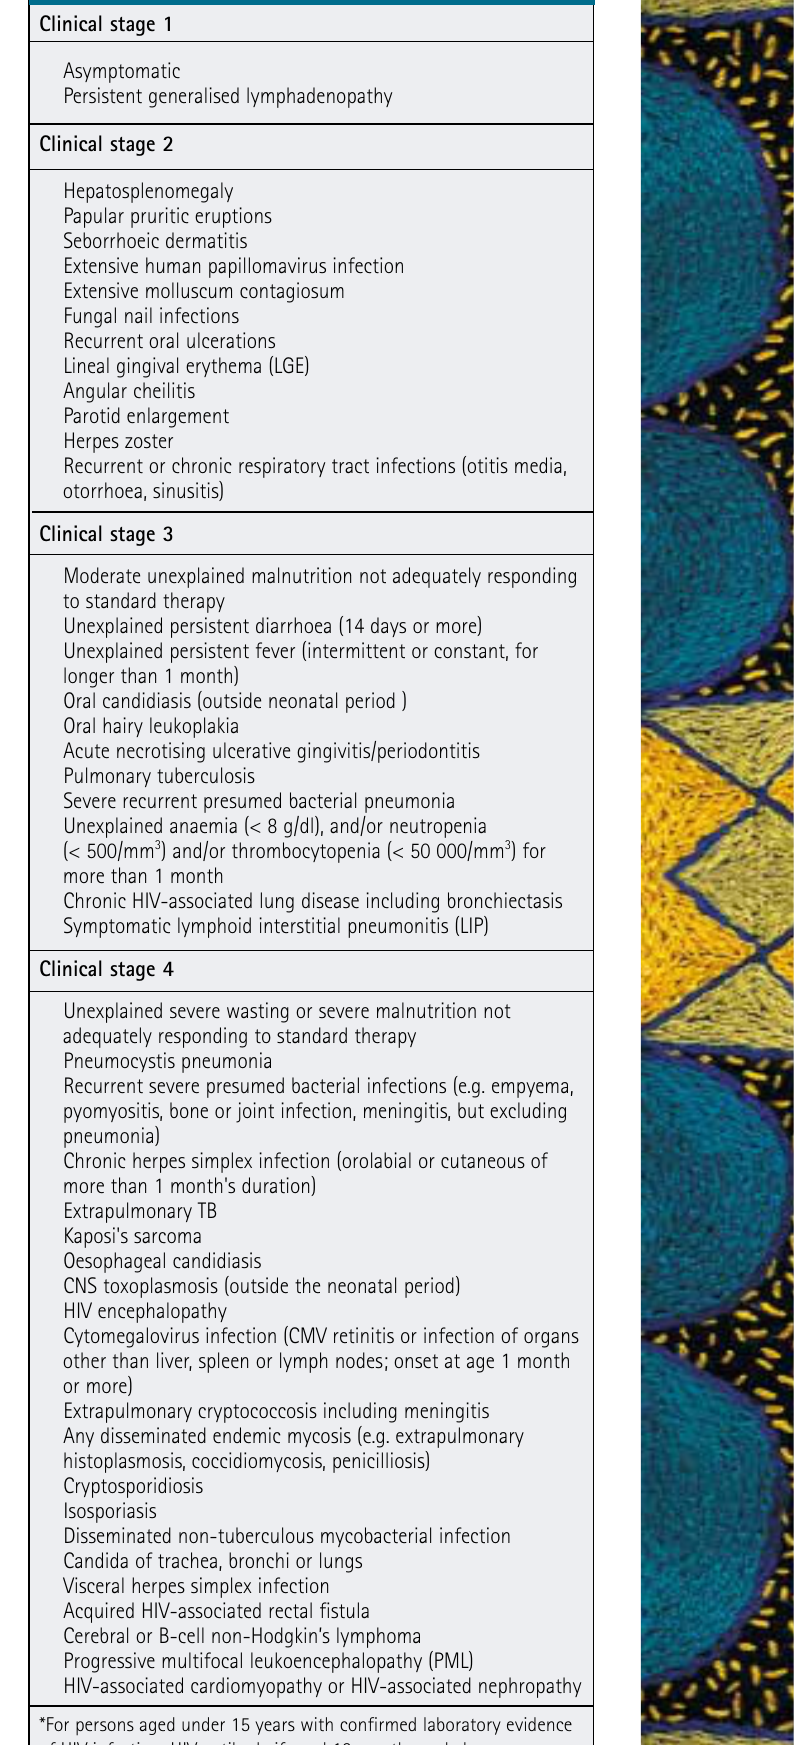
TABLE V. INTERIM REVISED WHO CLINICAL STAGING OF